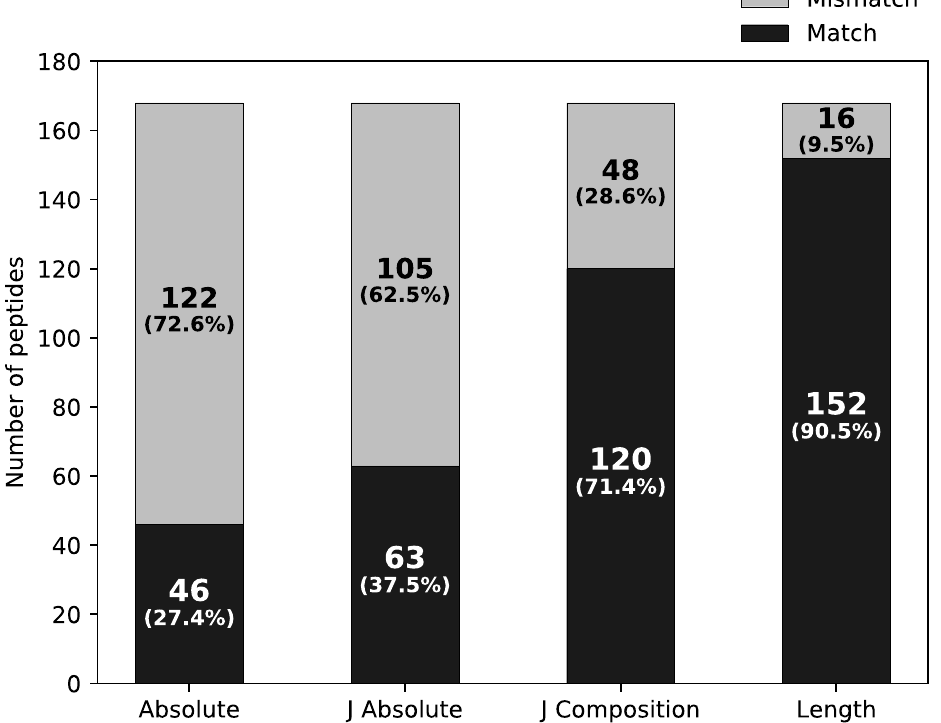
Figure 9. The dependence of the peptide matching specificity criteria on the peptide identification assignment discrepancy: absolute amino acid sequence match (Absolute), amino acid sequence match, where leucine (L) and isoleucine (I) were not differentiated and are annotated as “J” (J Absolute), amino acid composition match (J Composition) and peptide length match (Length).